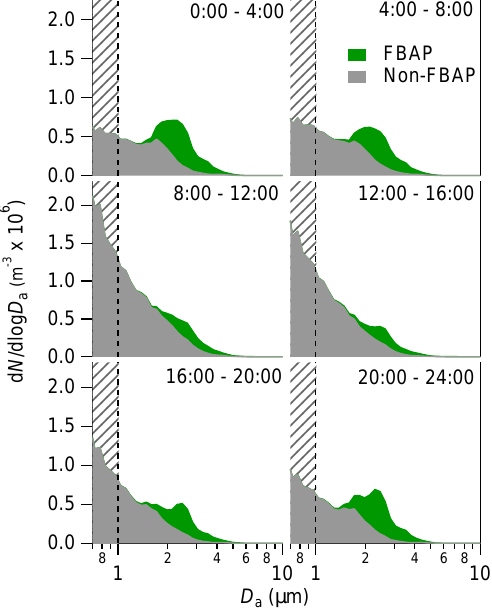
Fig. 9. Particle size distributions from UV-APS plotted as a function of time of day in four-hour blocks for Period 2 (4–15 March). FBAP stacked on top of non-FBAP in each